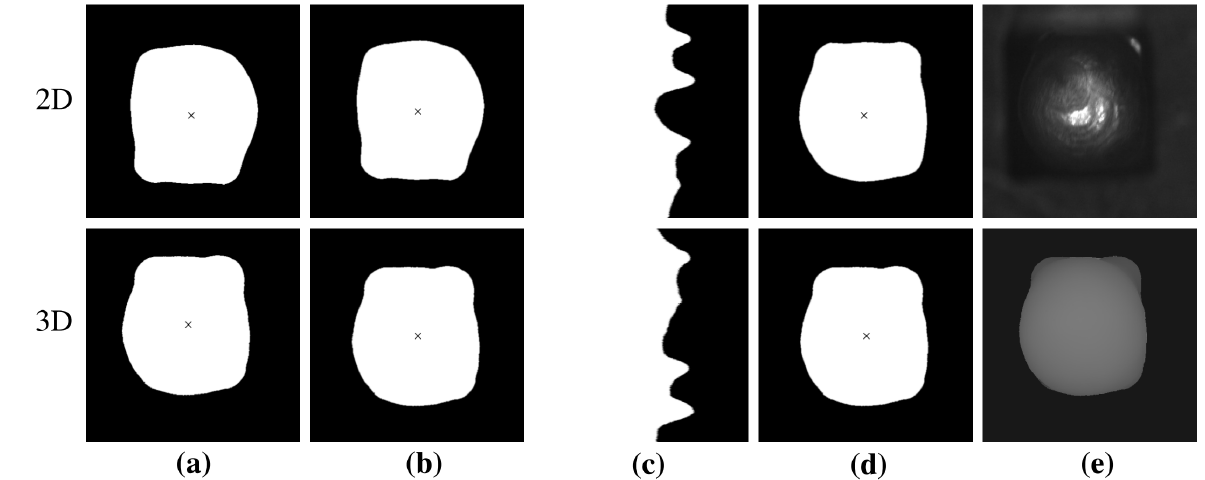
Figure 2. Mapping of the 2D and 3D images of a hairpin. The images of the upper row belong to the 2D image, the lower row to the 3D height profile. The raw data of the considered pin can be seen in Figure 1. ( a ) Masks of the 2D and 3D images learned with a neural network and their centers. In ( b ), the centers of both masks are translated at the center of the image. The images are transformed into polar coordinates, which can be seen in ( c ). In ( d ), the 2D mask is rotated. ( e ) Result of the mapping.